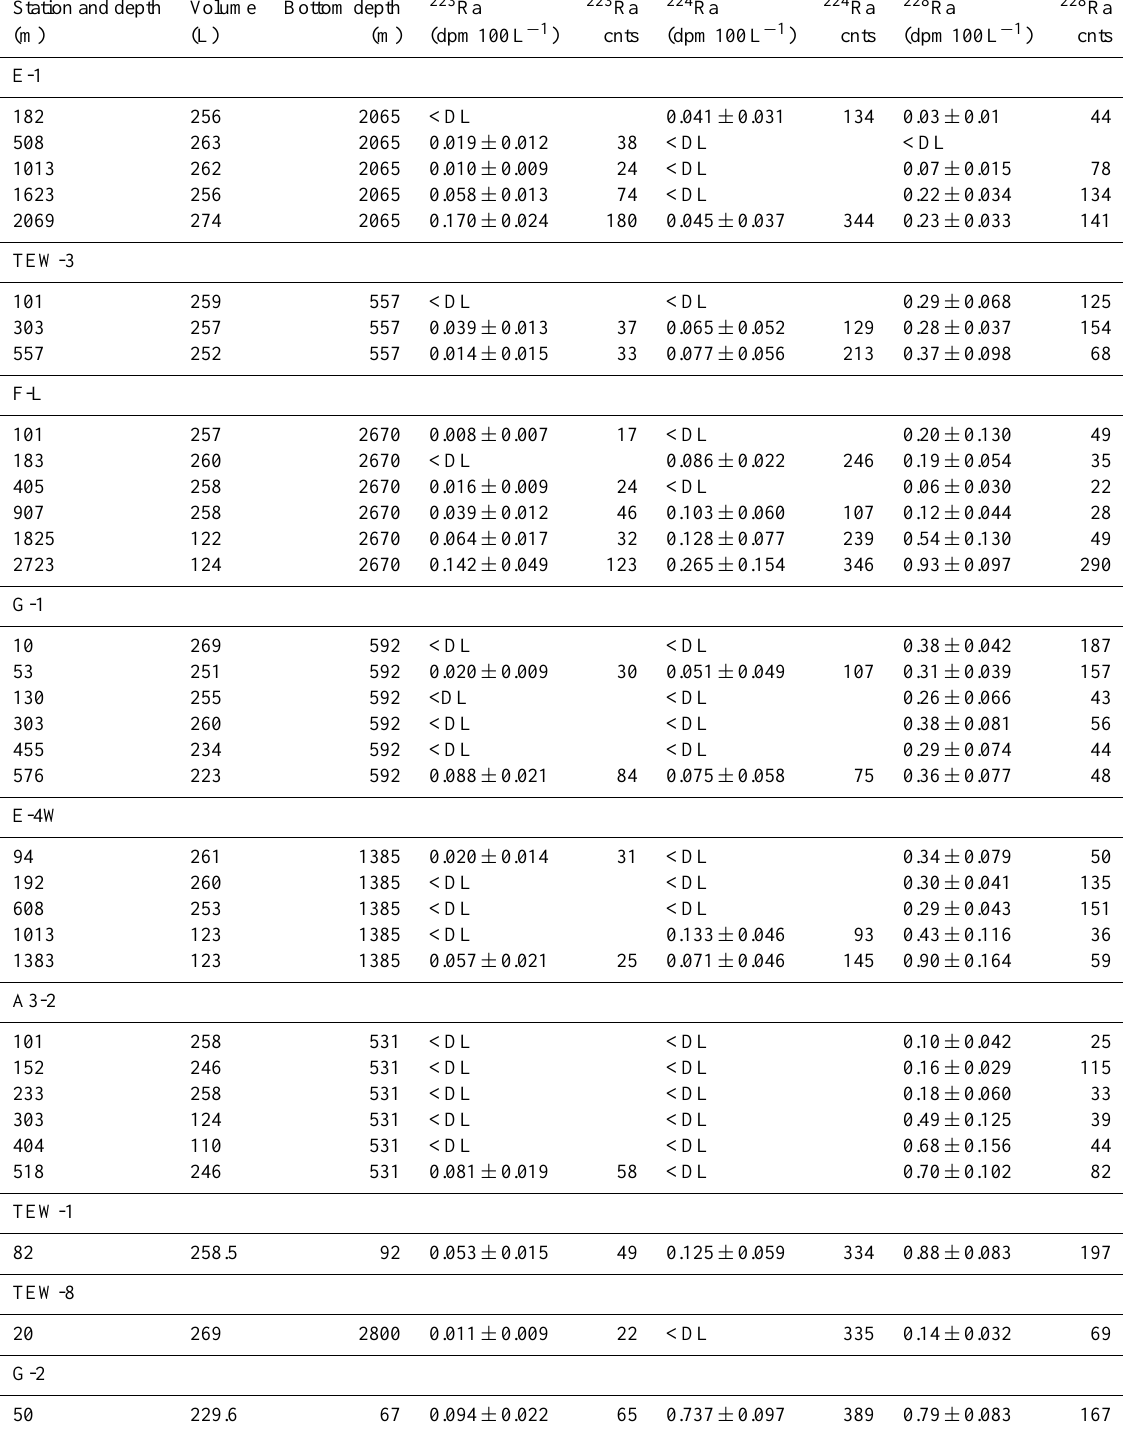
Table 2. Dissolved 223 Ra, 224 Ra and 228 Ra activities determined in seawater samples collected in the water column using Niskin bottles. The 223 Ra and 224 Ra activities are excess radium activities (see Methods for details). Activities are expressed in disintegration per minute per 100L (dpm100L − 1 ). The number of counts detected is also reported in the Table (cnts). <DL denotes below the detection